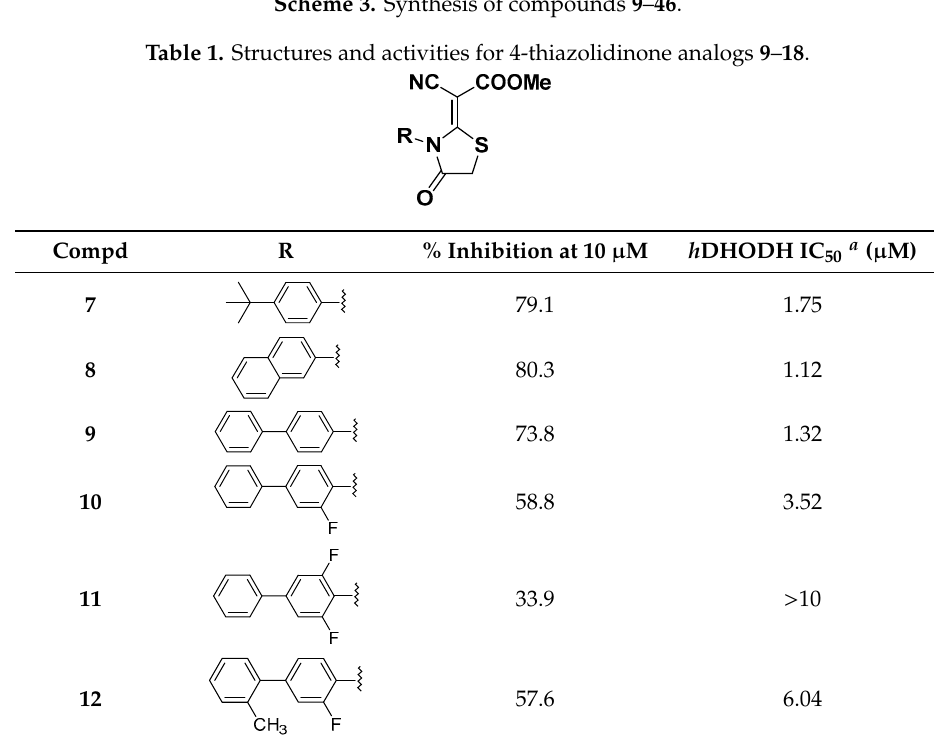
Table 1. Structures and activities for 4-thiazolidinone analogs 9 – 18.